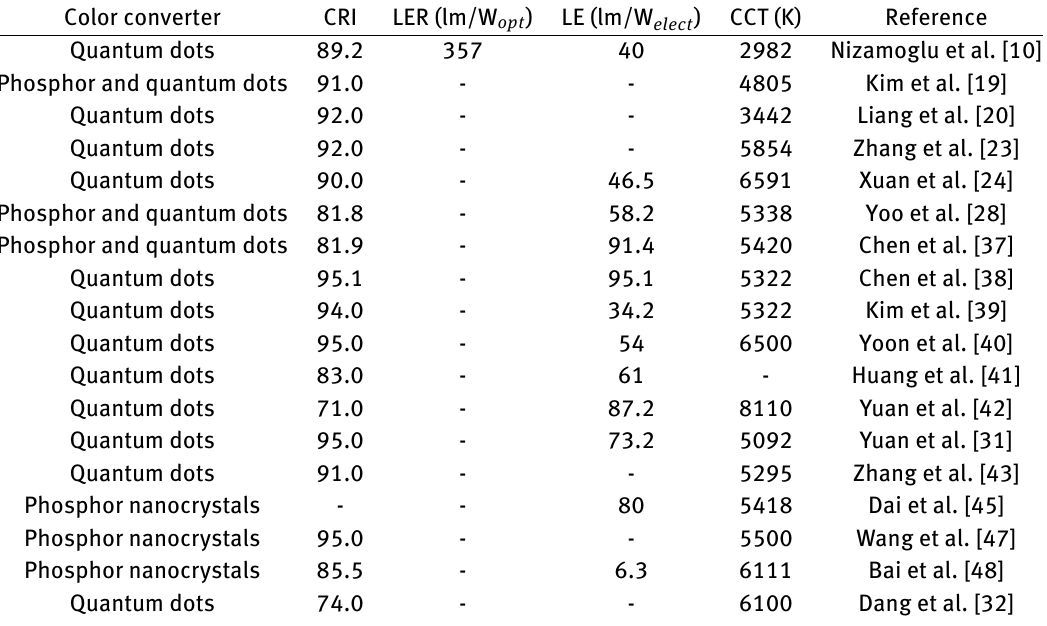
Table 1: Colorimetric and photometric performance of the white LEDs using color-converting colloidal materials highlighted in this review. Color